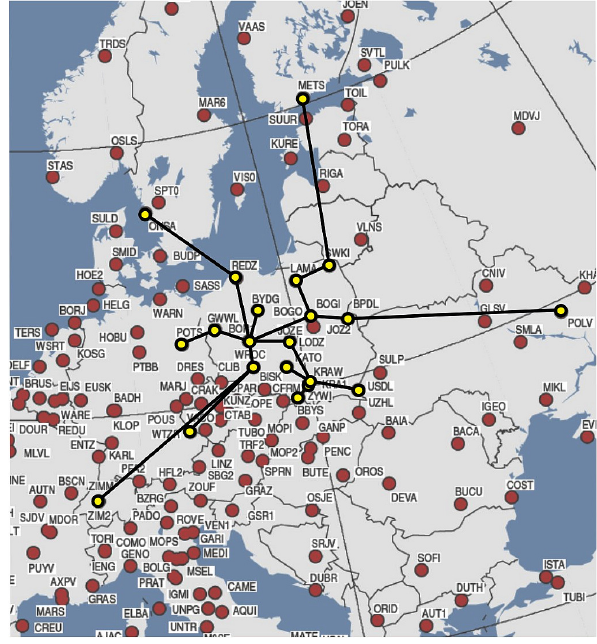
Fig. 6. Comparison of estimated NRT ZTDs with EPN combined ZTD solution for 19 EPN stations, during April and November of 2011.